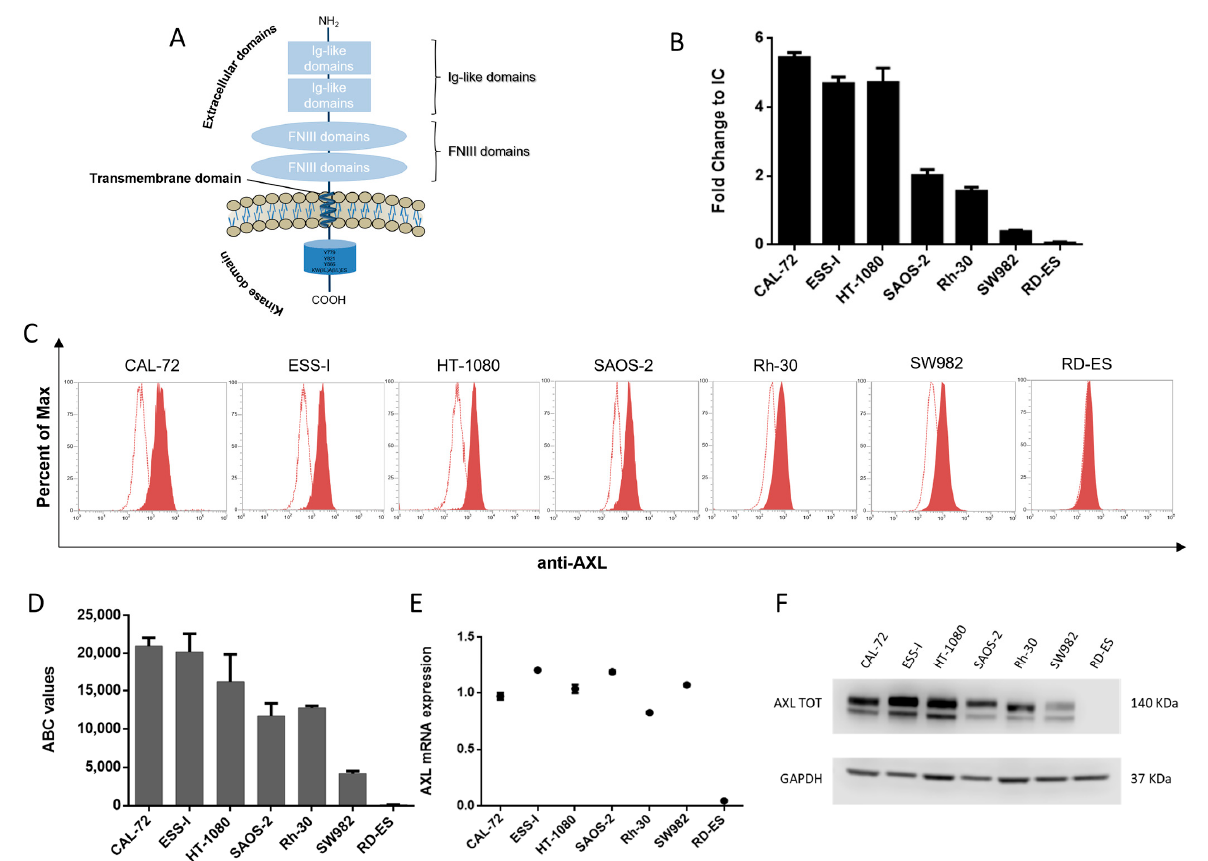
Figure 1. AXL expression. ( A ) Schematic representation of AXL receptor tyrosine kinase structure. It is composed of two immunoglobulin (Ig)-like domains that characterize extracellular domains, two fibronectin type III (FNIII) domains, a transmembrane domain and a kinase domain that is intracellular. ( B ) Flow cytometry analysis of AXL expression of sarcoma cells. ( C ) Representative FACS overlays between unstained (empty) and stained (full red) sample of each cell line. ( D ) Quantification of antibody-binding capacity (ABC) assay. ( E ) AXL-relative mRNA level determined by qRT-PCR and normalized on GAPDH housekeeping. ( F ) Western blot of AXL total form reported in a collection panel of sarcoma cells. The uncropped blots are shown in Figure